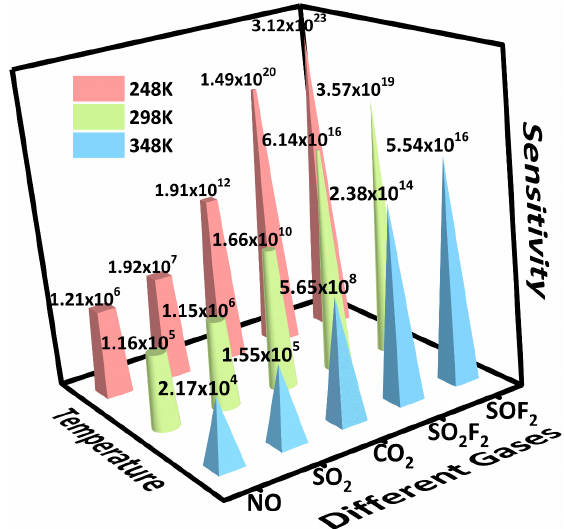
Figure 4. The sensitivity ( S ) of all adsorption